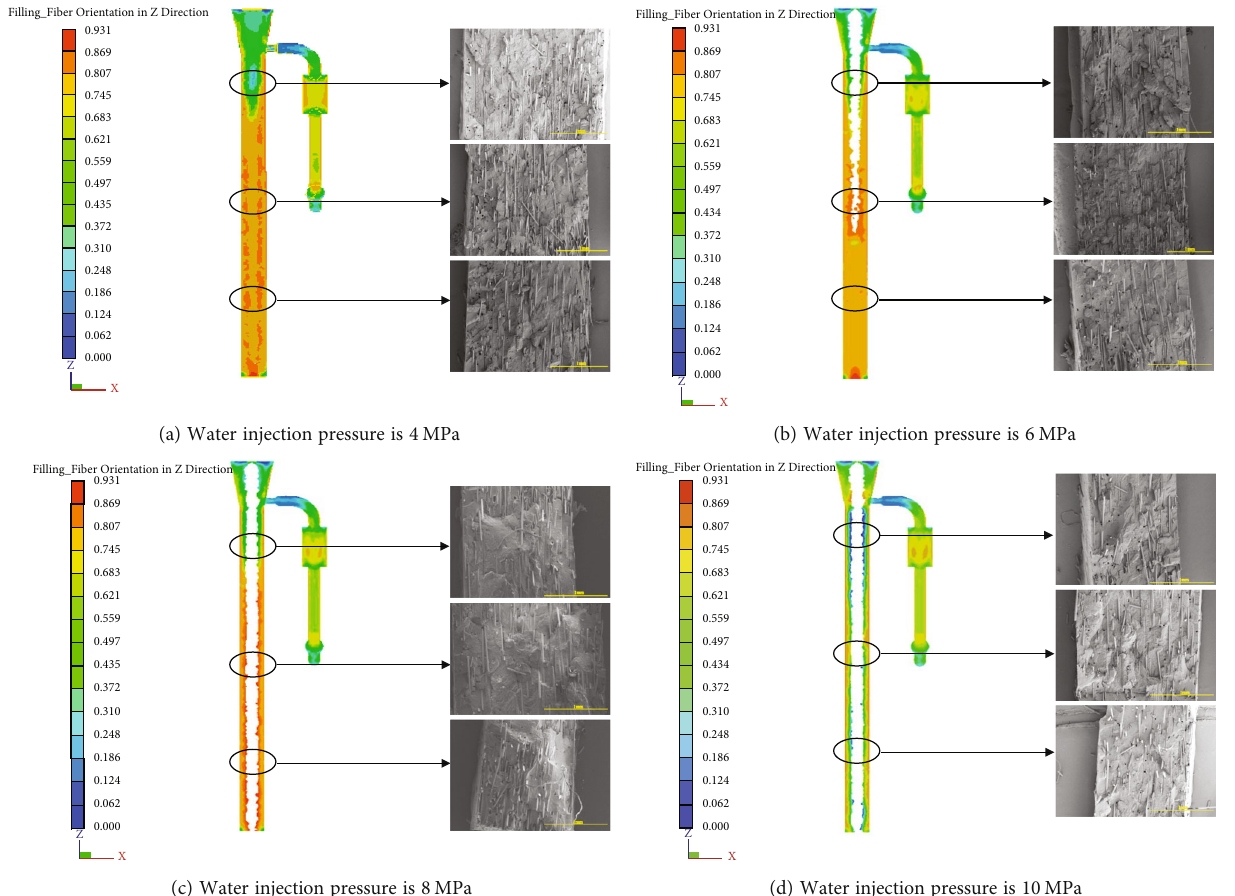
Figure 7: Fiber orientation distribution along the fl ow direction at di ff erent water injection pressure.